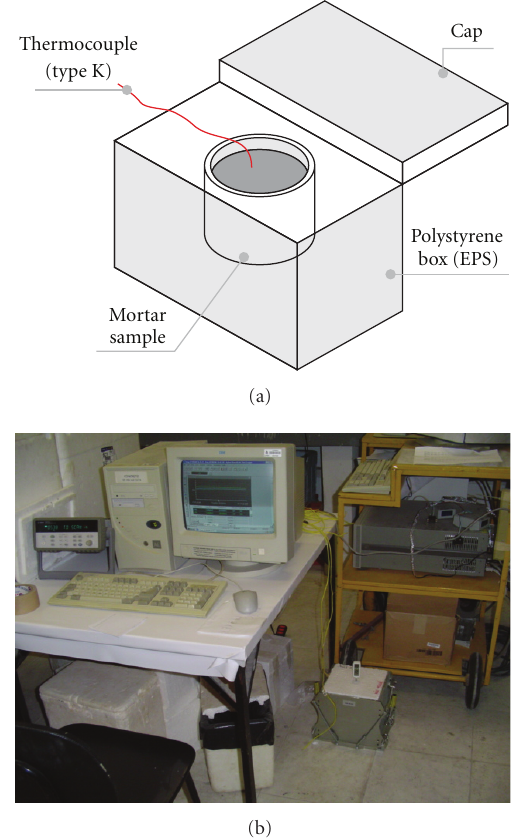
Figure 1: (a) EPS box and (b) datalogger used to measure and determine the time-temperature curve for the mortar